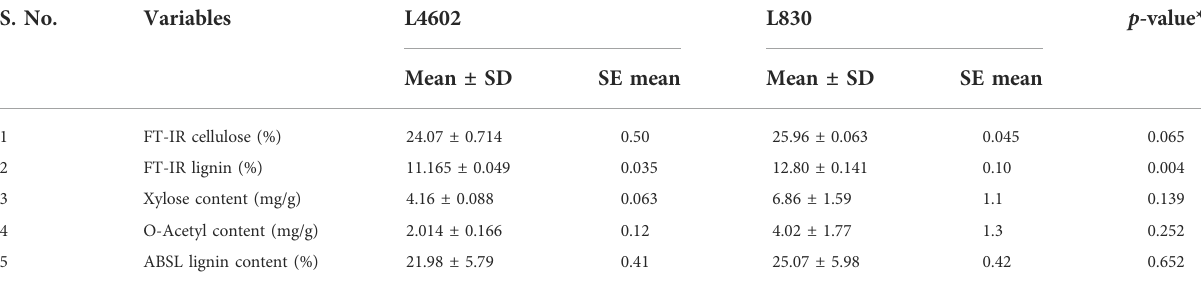
TABLE 6 Estimation of cellulose, lignin, acetyl bromide soluble lignin content, D-xylose, and acetylated xylose in the mature lentil seeds of the genotypes L4602 and L830. S.